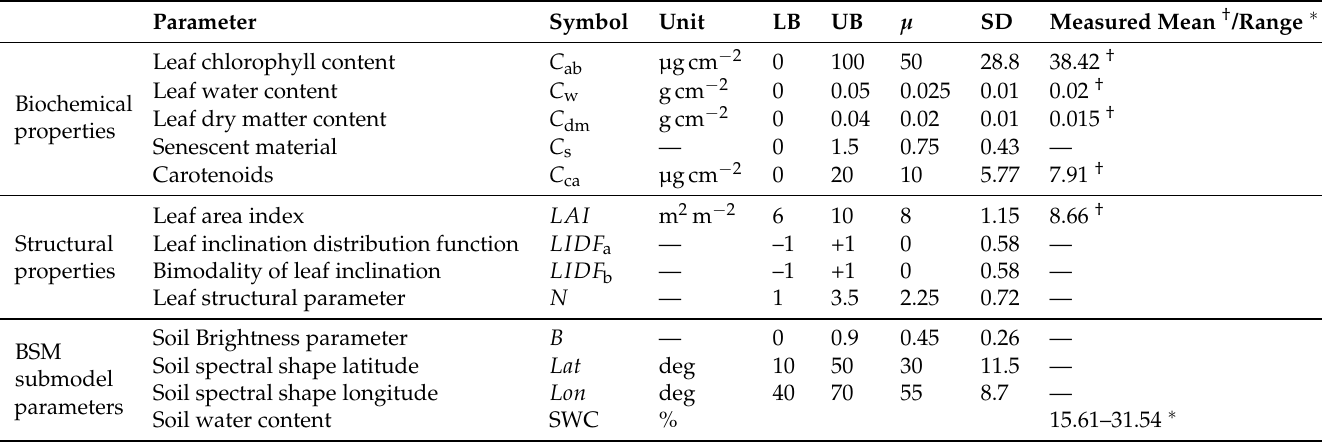
Table 2. Input parameters for the radiative transfer module (RTMo) of the Soil Canopy Observation of Photosynthesis and Energy fluxes (SCOPE) model together with the lower bound (LB), upper bound (UP), prior mean ( µ ), prior standard deviation (SD), and mean of the measurements acquired in August 2016 from three field sampling plots (Figure 1). The range of the measured soil water content (SWC) in the brightness-shape-moisture (BSM) submodel is provided from Table